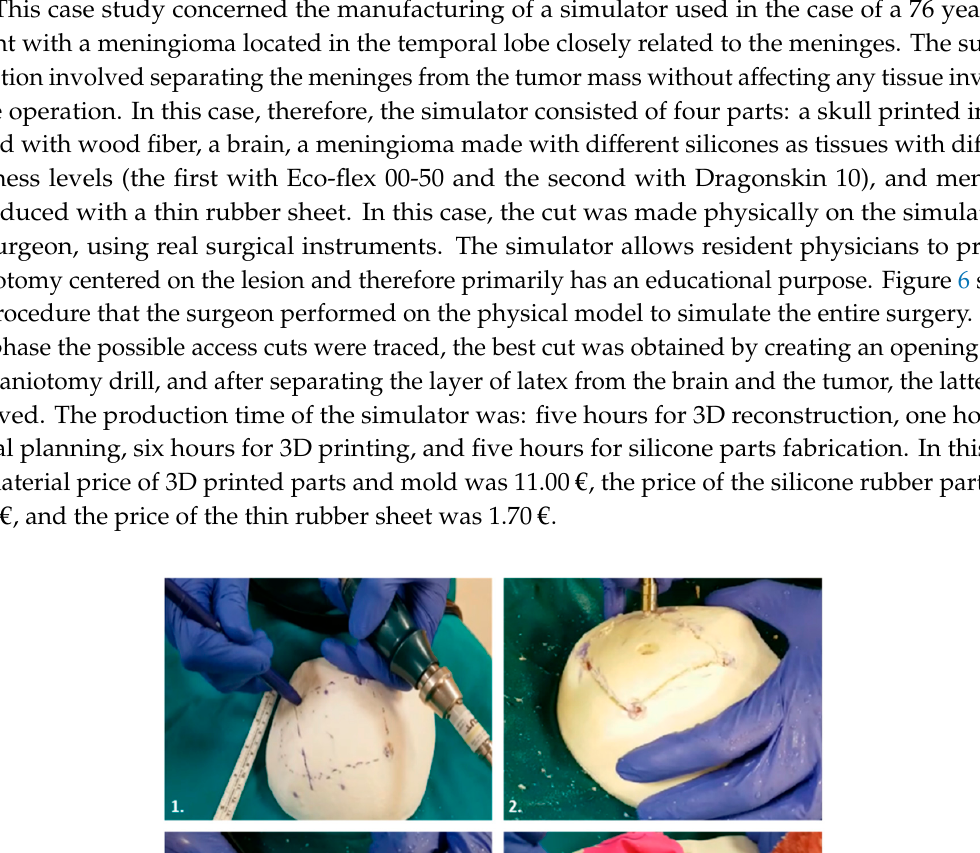
Figure 5. Different views of the biomodel that consisted of a skull, brain, and tumor.